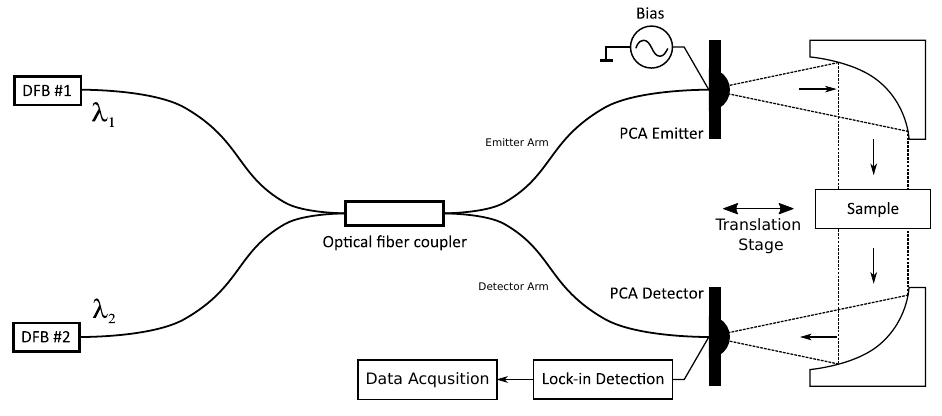
Figure 1. THz-FDS